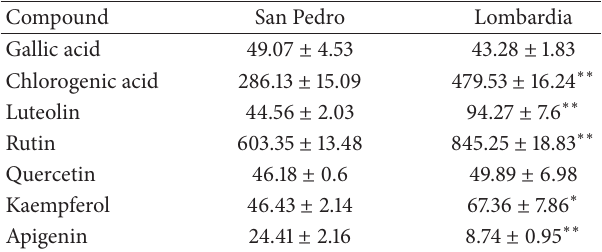
Table 4: Characterization ( 𝜇 g/g dry matter) of polyphenolic com- pounds separated by